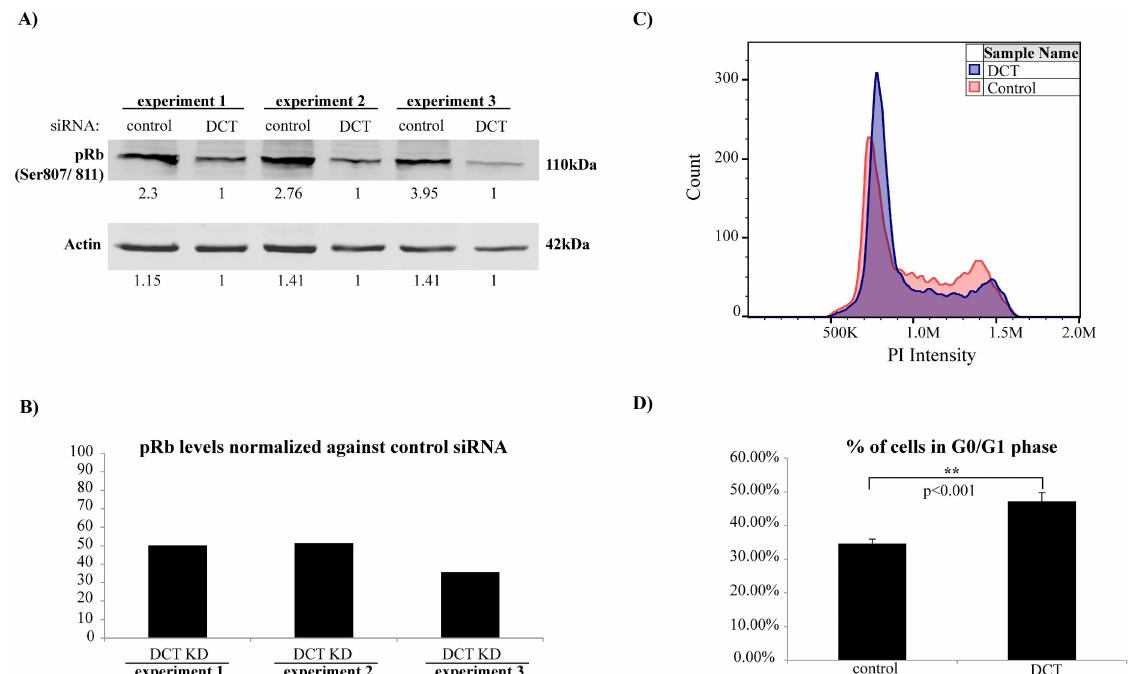
Fig 9. Cell cycle progression is altered in DCT knockdown cells compared to control cells. (A) Cell lysates from control and DCT knockdown cells were harvestedand subjectedto western blotting on the day of the knockdown. pRb (Ser807/811) and actin levels are shown for three independentDCT knockdownexperiments. (B) pRb band intensities of each lane were quantified and normalized first againstthe corresponding actin measurements and then againstthe normalized pRb levels in control samples. The bar graph shows the normalizedpRb levels of DCT knockdown cells comparedto their controls. (C) Representative cell cycle profiles for DCT knockdown and control cells as analyzedand visualizedby FlowJo v10. (D) Cell cycle profiles of DCT knockdown and control cells were analyzedby PI staining and flow cytometer. The bar graph shows the mean value of the percentageof cells in G0/G1 phase for three independent experiments with six replicates each (one tailed t-test p =